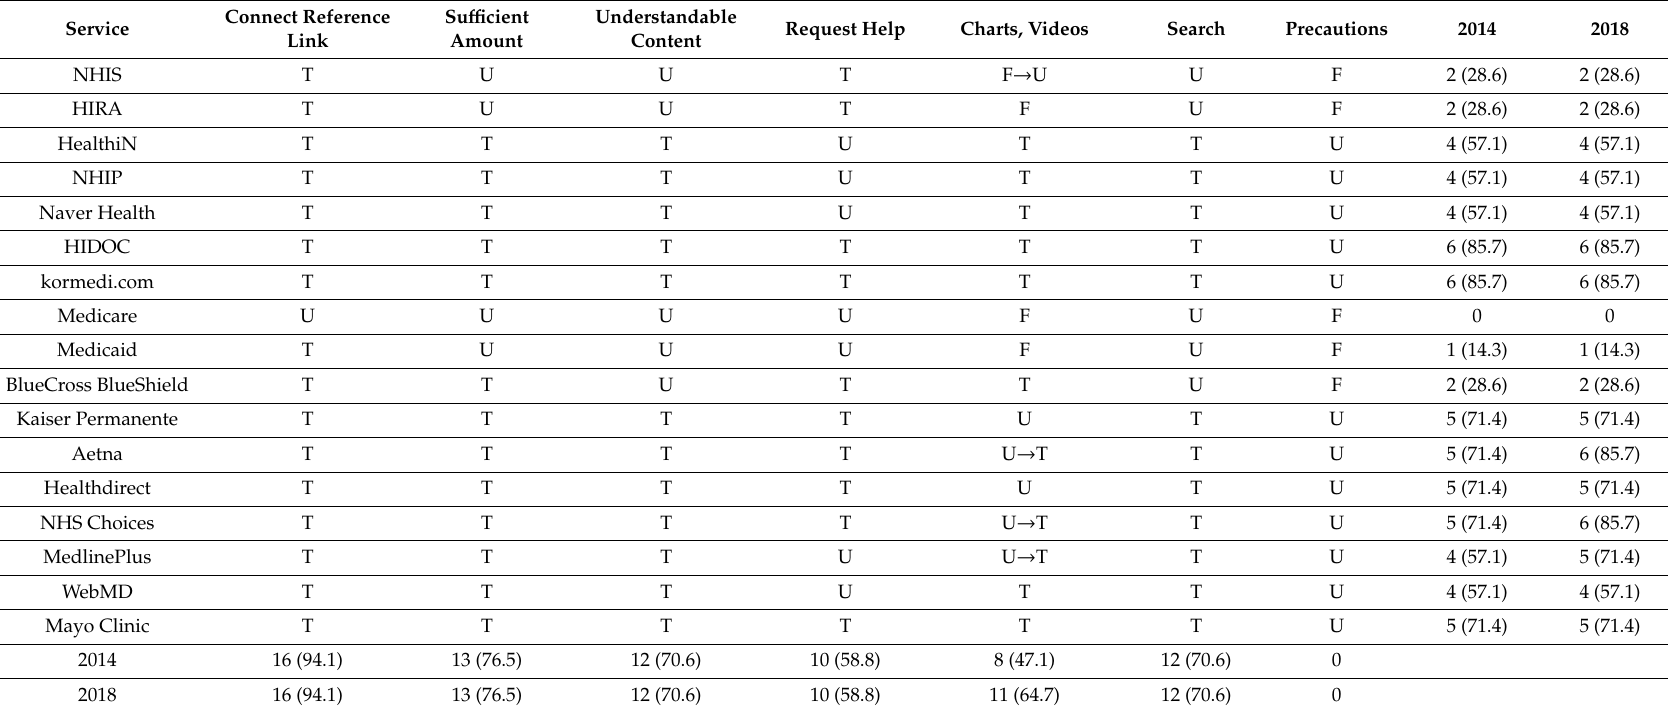
Table 6. Changes in the service characteristics of health information portals (frequency,